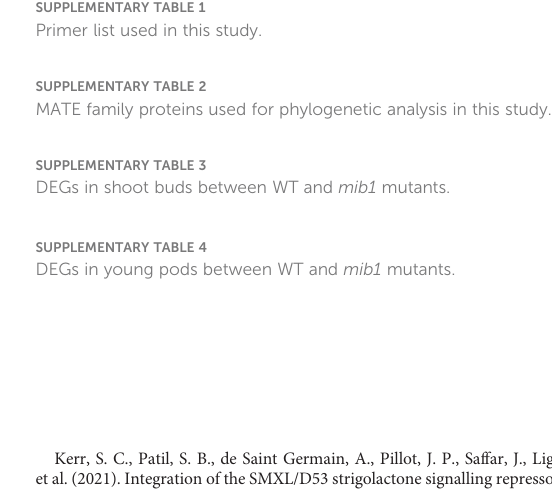
SUPPLEMENTARY TABLE 1 Primer list used in this study.